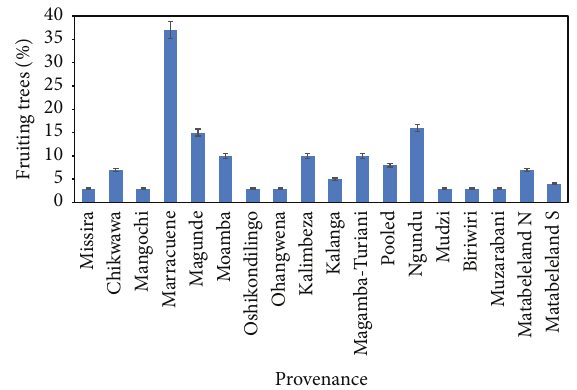
Figure 2: Percentage of fruiting trees within provenances of Sclero- carya birrea in Malawi.